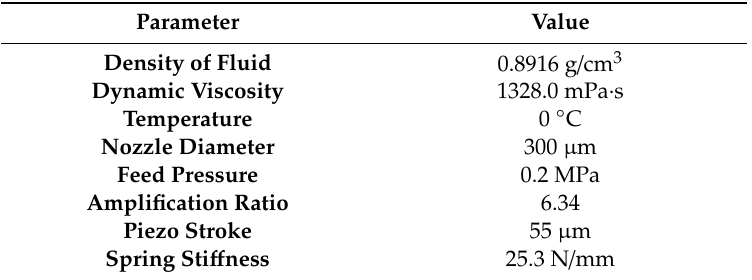
Table 2. Parameters and their values used in the simulation.